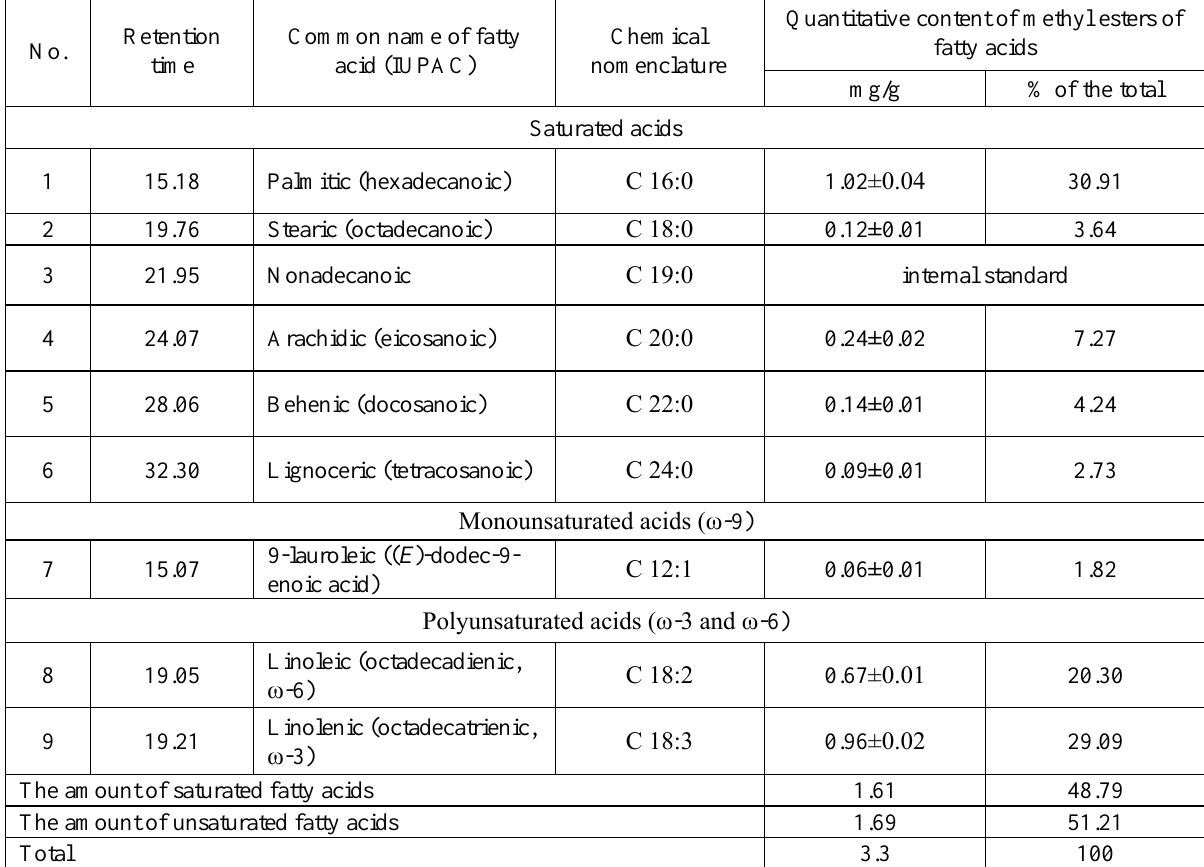
Fig. 1. GC/MS chromatogram of fatty acids in Arnica foliosa Nutt. herb The results of fatty acids determination in Arnica foliosa Nutt.